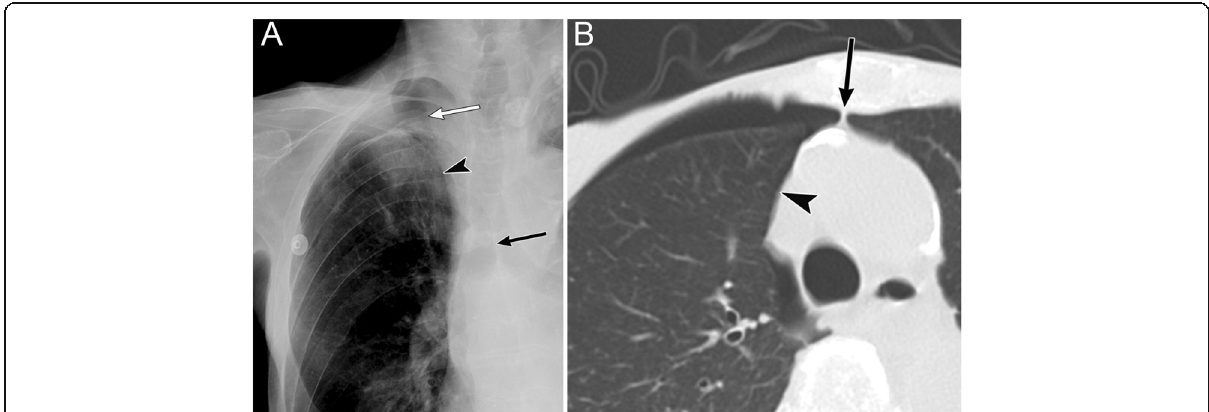
Fig. 2 Pneumothorax in the suprahilar anteromedial space of an 83-year-old man with enteritis. a A supine radiograph shows sharp delineation of the superior vena cava (SVC) (arrowhead), right brachiocephalic vein (white arrow), and anterior junction line (black arrow). b Axial CT image at the level of the SVC shows air collection in the pleural cavity on the right sides of the SVC (arrowhead) and the anterior junction line (black arrow)